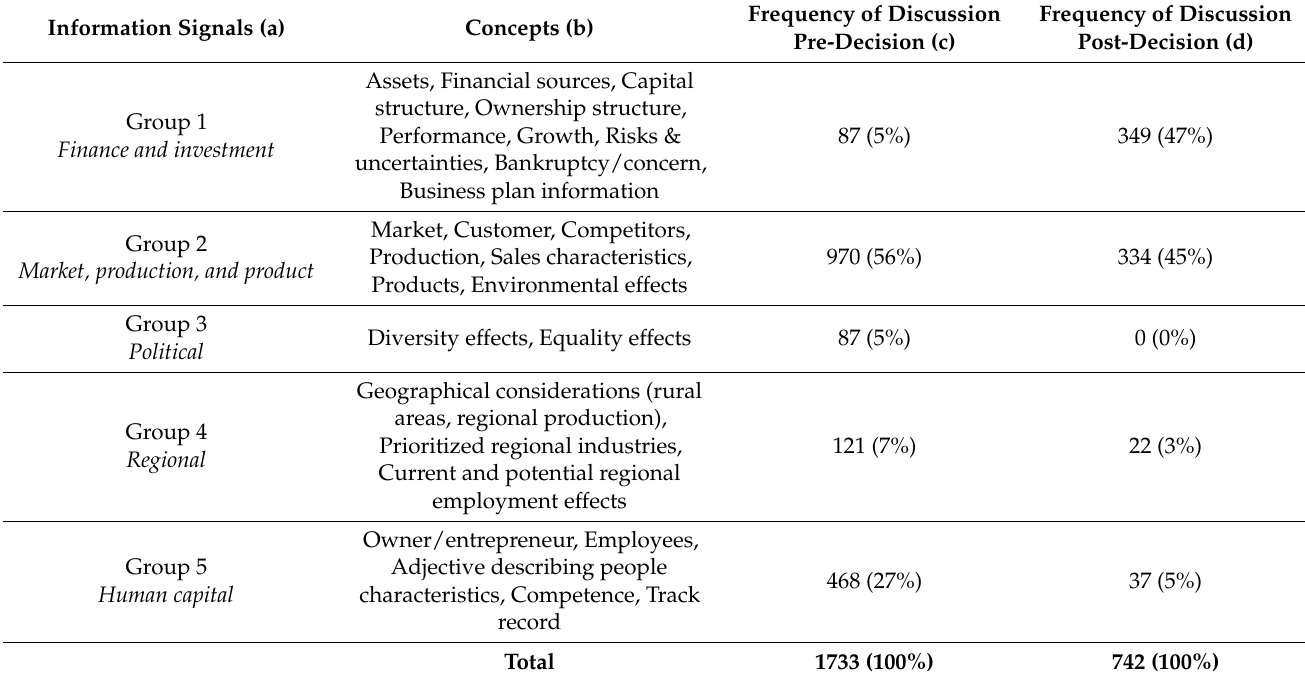
Table 1. Adopted information